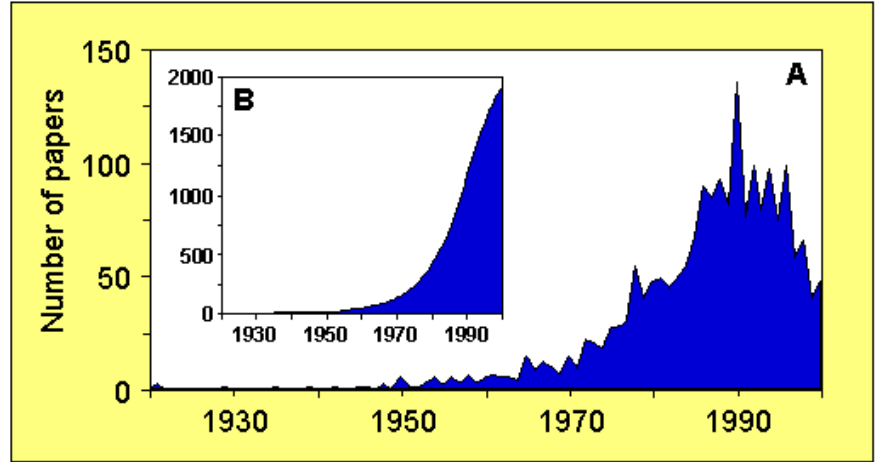
FIGURE 1. (A) Number of published scientific articles concerning the effects of fish in lake ecosystems. (B) Inset shows cumulative summary. The database used for this figure can be found at